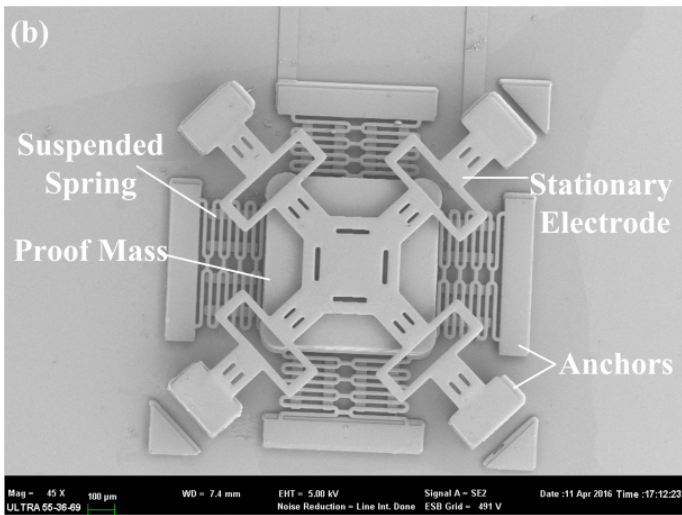
Figure 14. SEM photos of the fabricated inertial microswitch ( a ) with a cross beam as the stationary electrode in sample 1 and ( b ) with a mouth-shape cross beam as the stationary electrode in sample 2.